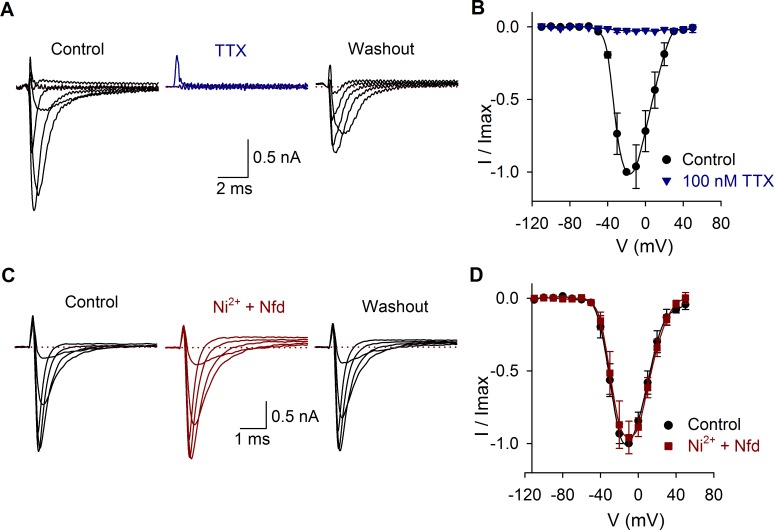
Effects of TTX, nickel and nifedipine on the INa.A) INa produced by voltage pulses from −110 mV to 50 mV in control conditions, during 100 nM TTX perfusion and 2 min after washout. In this and the following figures, only representative traces are shown. B) Current-voltage relationship in control conditions (black) and with TTX perfusion (blue). C) Current recording in control conditions and after coapplication of 10 μM nifedipine (Nfd) and 100 μM nickel. D) Current-voltage relationship in control conditions (black) and with Ni2+ plus nifedipine perfusion (red). In all traces, the dotted line indicates zero current.